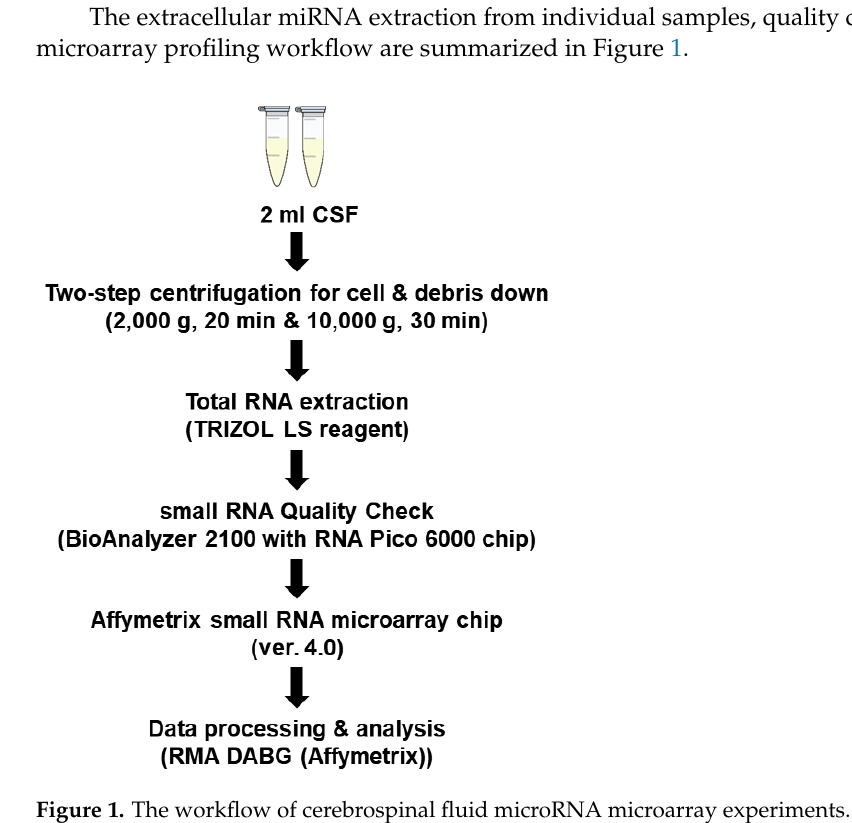
Figure 1. The workflow of cerebrospinal fluid microRNA microarray experiments.